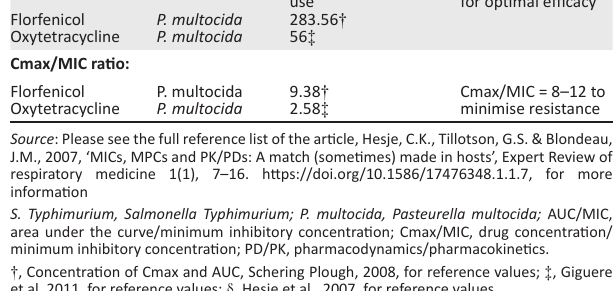
TABLE 4 : Combined summaries of the pharmacodynamic/pharmacokinetic data for the results obtained for Pasteurella multocida and Salmonella Typhimurium using reference values from previous